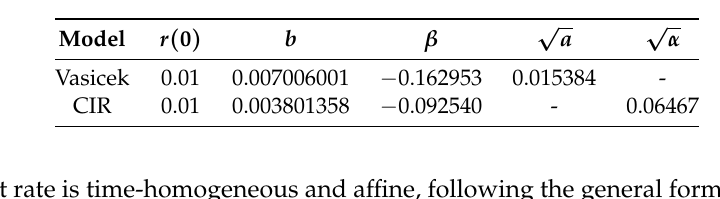
Table 1. Parameters for the two interest rate models: the Vasicek model ( α = 0) and the CIR model ( a = 0). Model r ( 0 ) b β Vasicek 0.01 0.007006001 − 0.162953 0.015384 - CIR 0.01